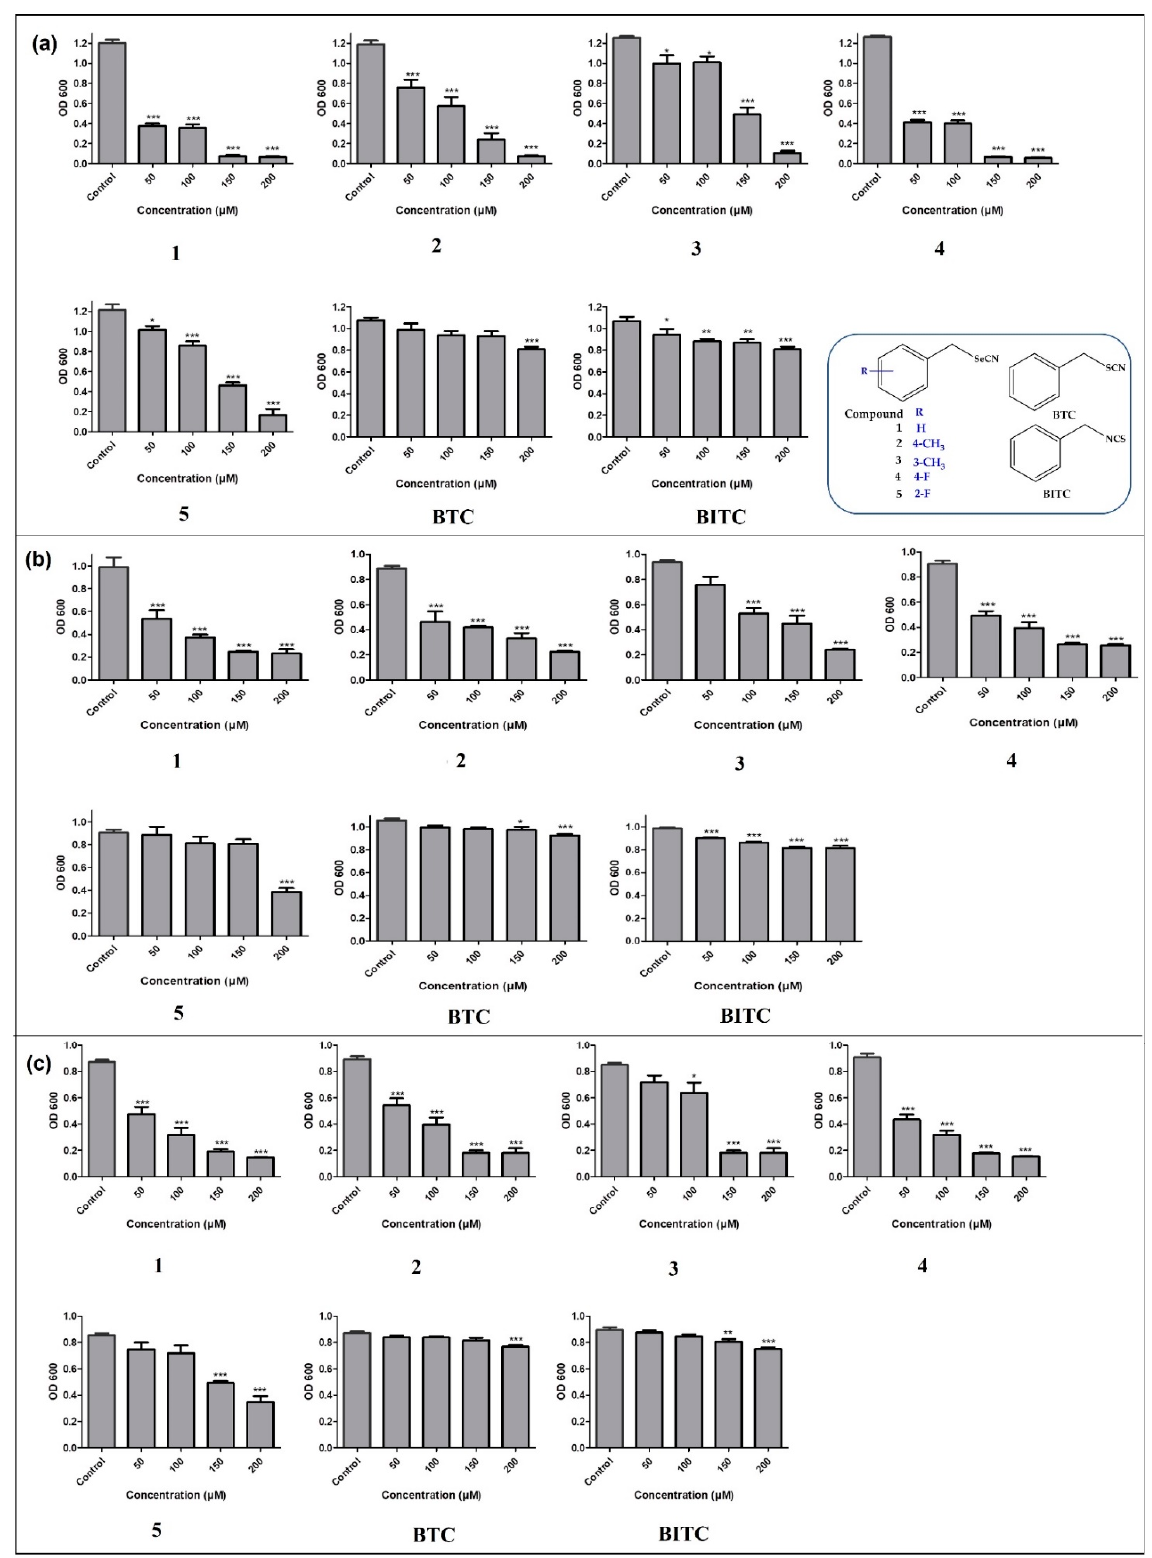
Figure 2. Impact of selenocyanates and thiocyanates on the growth of E. coli (Panel ( a )), P. syringae (Panel ( b )), and M. luteus (Panel ( c )). The insert in Panel a represents the chemical structures of compounds employed in this study. Values represent mean ± S.D. * p < 0.05, ** p < 0.01 and *** p < 0.001. See text for further experimental